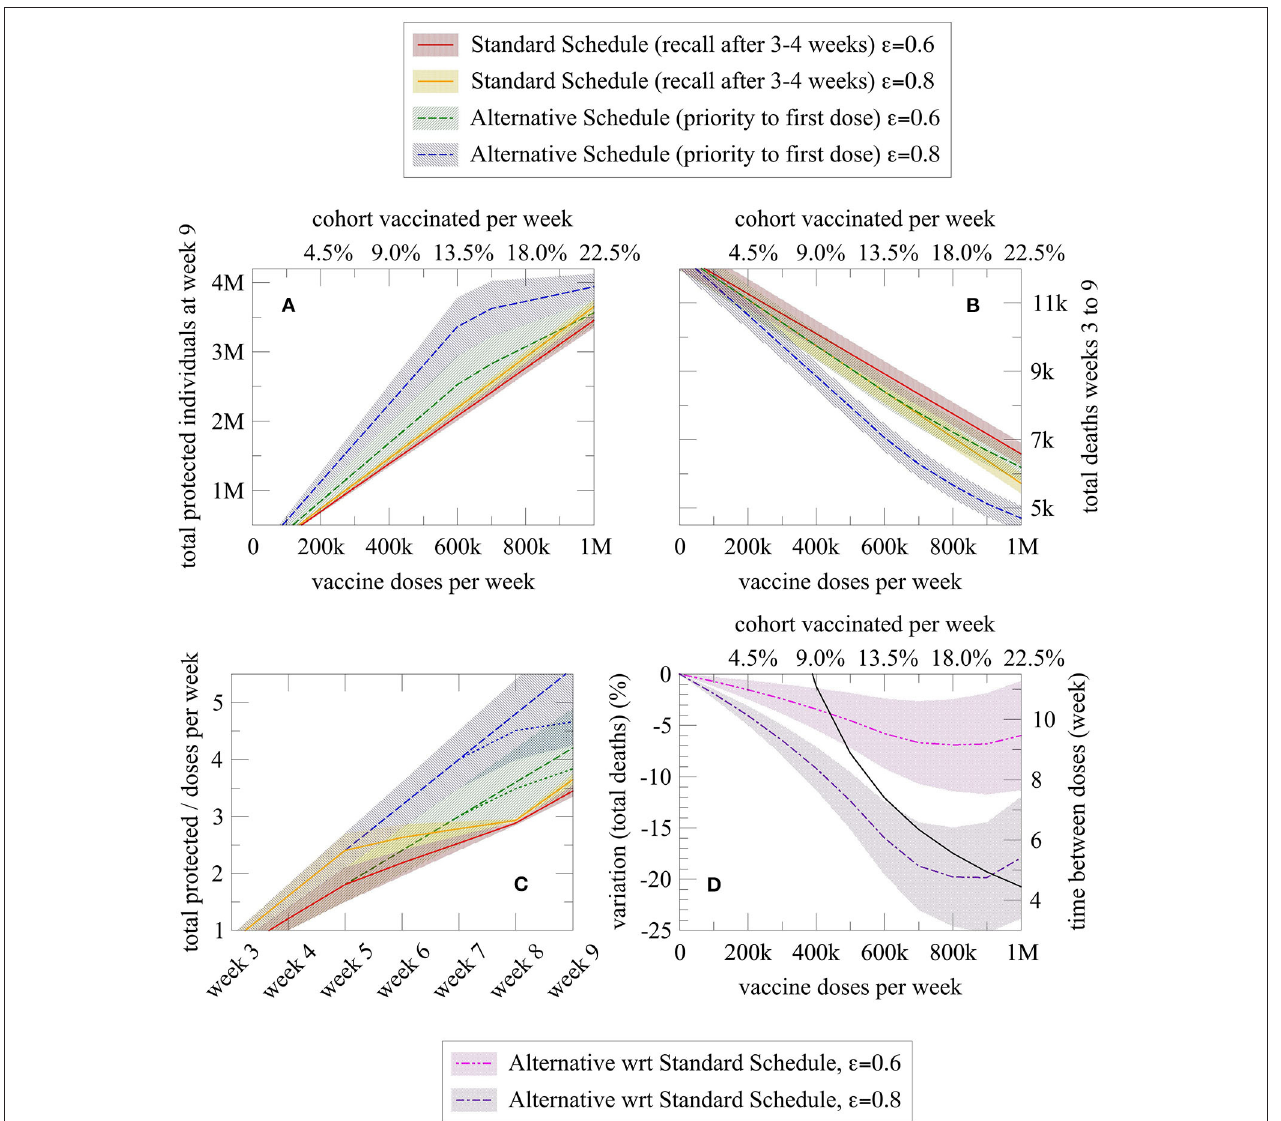
FIGURE 2 | Graphical representation of the number of protected and dead individuals as a function of different variables, for a given vaccination schedule (alternative vs. standard). Each schedule is represented by two lines, one for vaccine effectiveness of 80% (blue for alternative schedule and orange for the standard schedule) and one for vaccine effectiveness of 60% (green for alternative schedule and red for the standard schedule). (A) Total protected individuals at week 9 and (B) Total deaths from week 3 to 9 as a function of the number of doses administered per week (or equally expressed as the percentage of the cohort vaccinated each week); (C) Efficiency index ( = protected individuals per doses administered over time) of the alternative and standard schedule as a function of the elapsed weeks (dashed sublines indicated a higher number of doses administered, namely 800,000 per week); and (D) Death reduction with the alternative schedule (purple line for an 80% vaccine effectiveness and pink line for a 60% vaccine effectiveness) compared with the standard schedule, and effective week in which administration of second doses begins in the alternative schedule after the entire cohort has received the first dose of vaccine (black line). In all plots, the shaded region denotes the confidence interval derived from the uncertainty associated with the effectiveness of the first dose and mortality